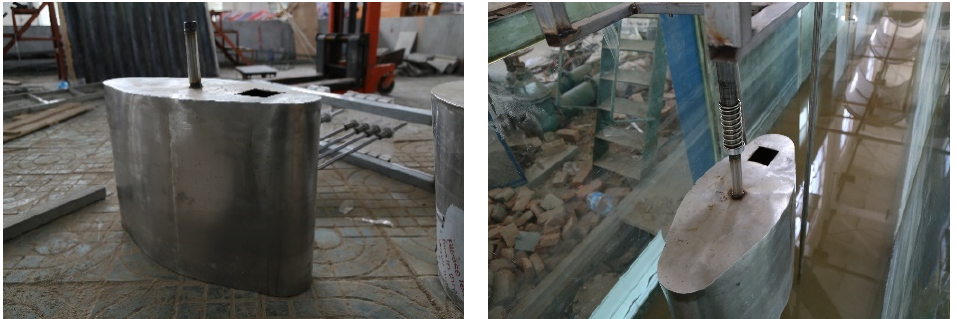
Figure 3. The elliptical cylinder of oscillating buoy. The buoy adopted permanent magnet single phase linear motor which was arranged 33 m away from the end of the flume (Figure 4). The lead wires of the three disk windings of the primary part of the motor (stator) were connected successively in series. A spring structure was installed at the end of the secondary part of the motor (rotor) to adjust its motion length according to the actual wave height. The rotor was connected with an el- liptical cylindrical buoy and the buoy floated on the water surface. The stator was fixed on the flume, and the primary winding was connected with the rectifier circuit (including the load bulb and electric power recorder). The detailed information of motor’s perfor- mance has been stated by Yu et al. [37] and Huang et al. [38]. The voltage and current signals outputted from the motor were collected and recorded by the electric power re- corder. The overall arrangement of the WEC experimental devices in this study is shown